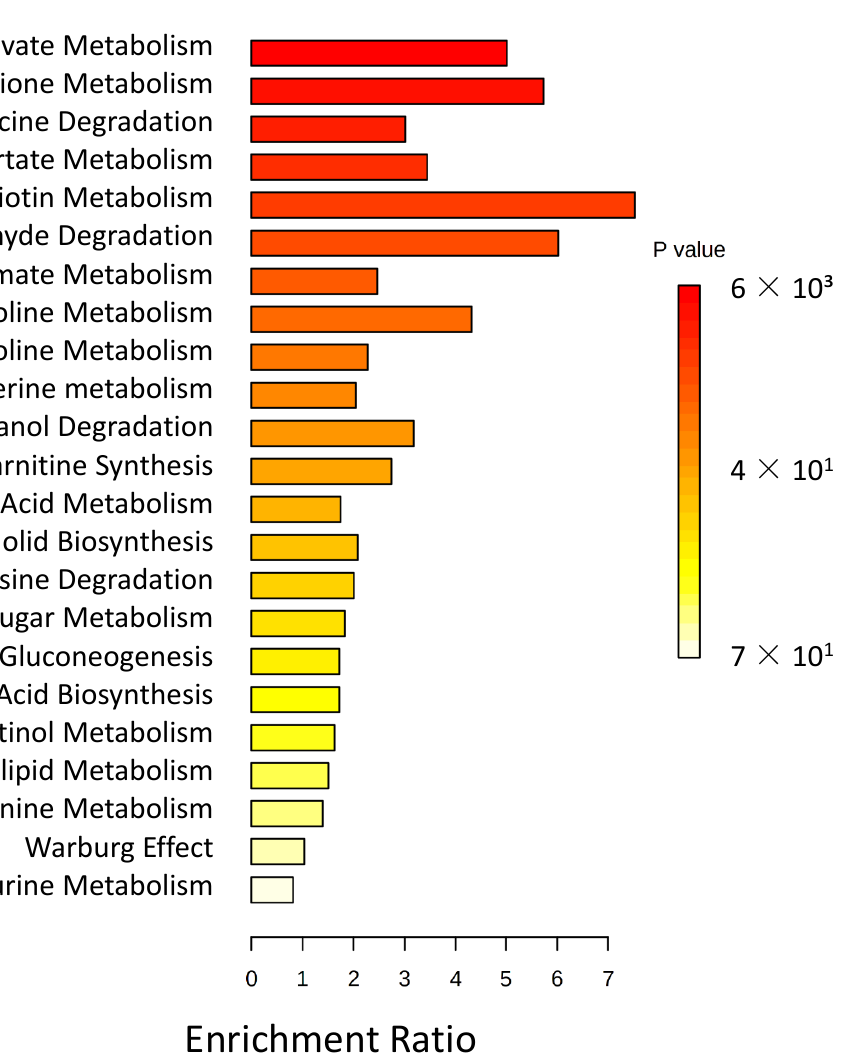
Figure 4. Pathway enrichment overview of metabolomic changes in RBCs of T1D obtained with Metaboanalyst.